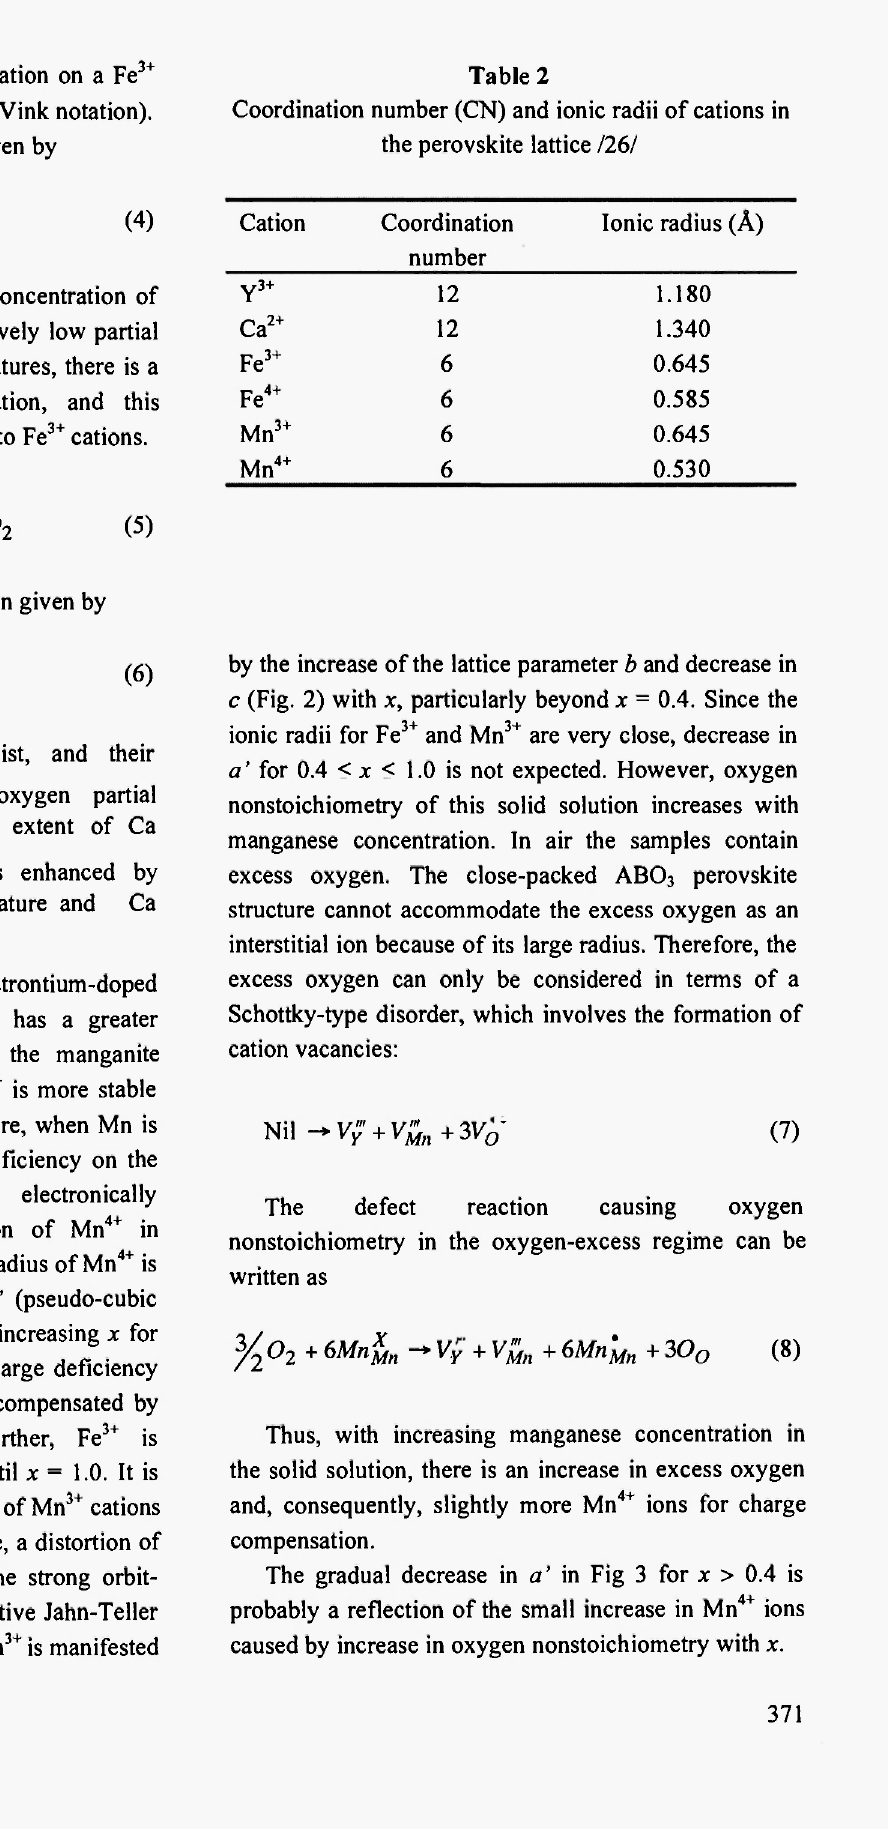
Coordination number (CN) and ionic radii of cations